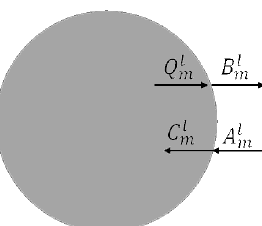
Figure 3. Cylindrical wave expansion coefficients; see the text.